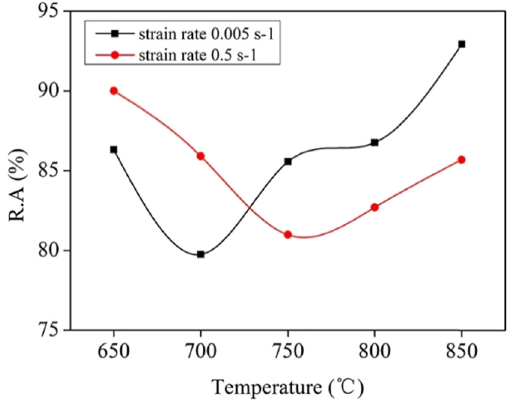
Figure 3: Hot ductility curves with a strain rate of 0.5 and 0.005 s − 1 of the base steel